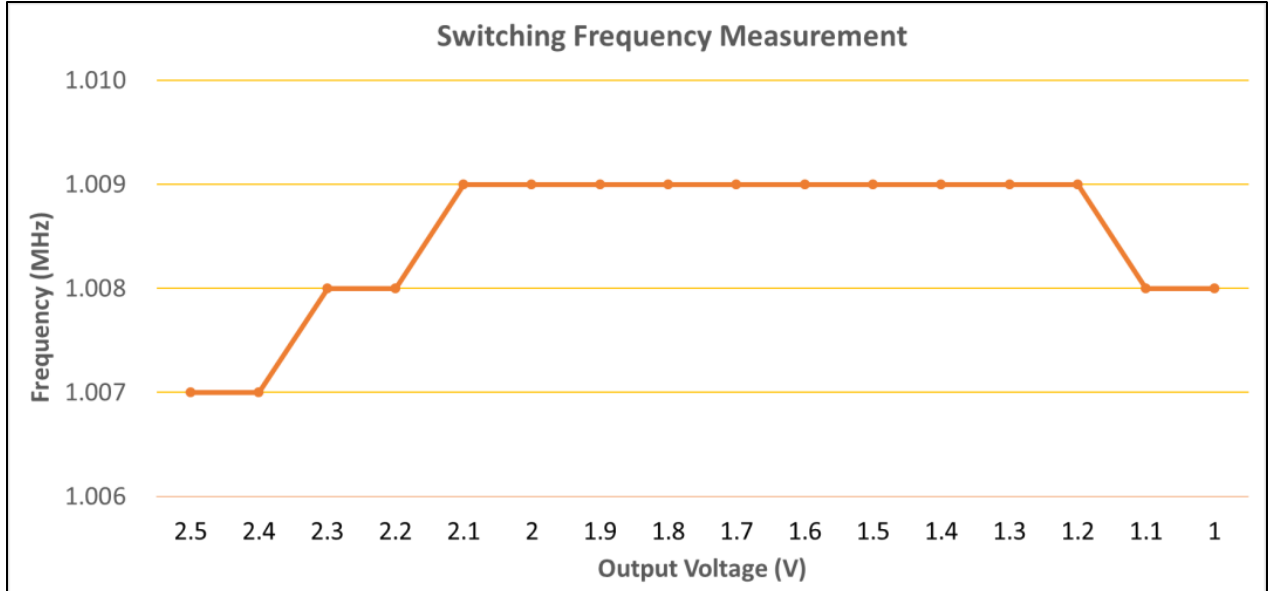
Figure 10. The switching frequency results.